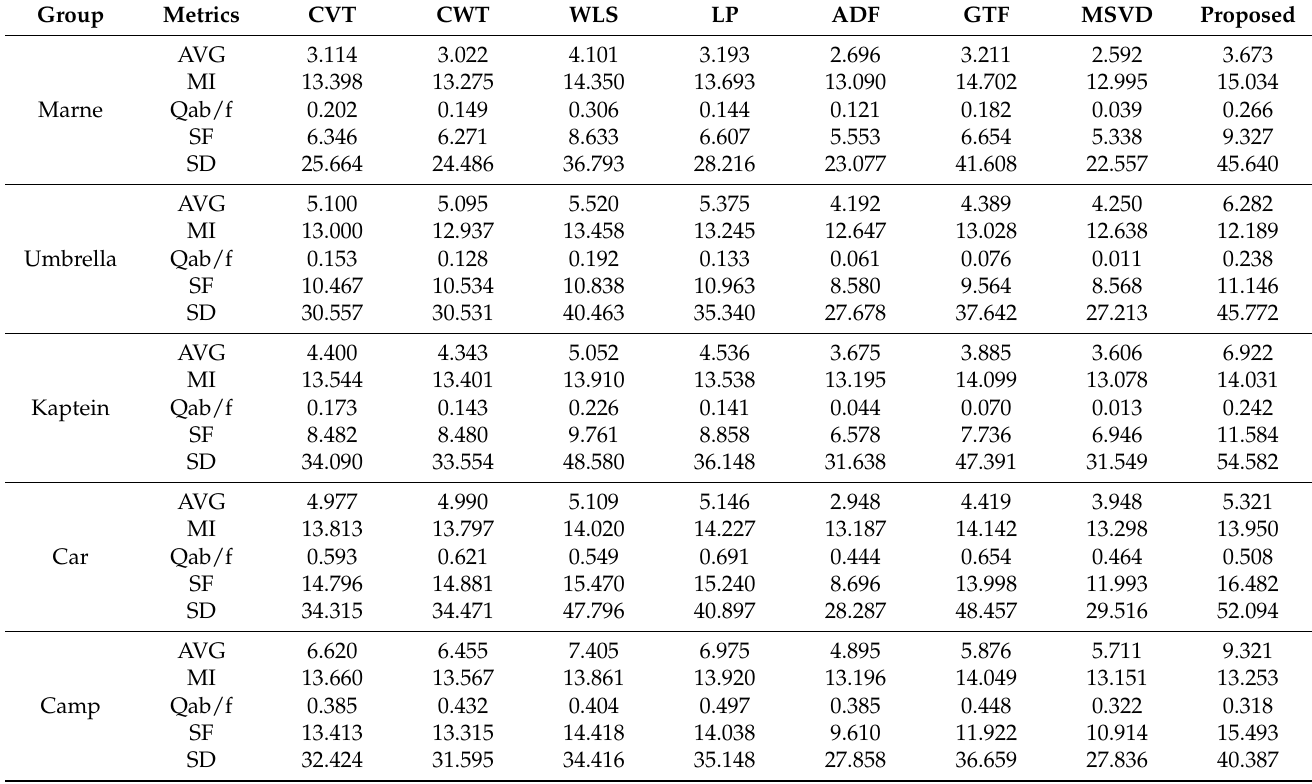
Table 1. The objective evaluation results for